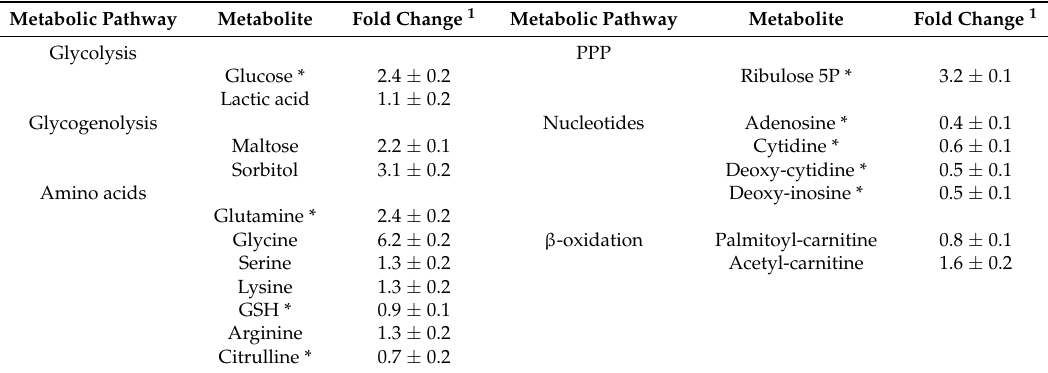
Table 1. Fold induction for the indicated metabolites measured upon in vivo treatment with AAE.